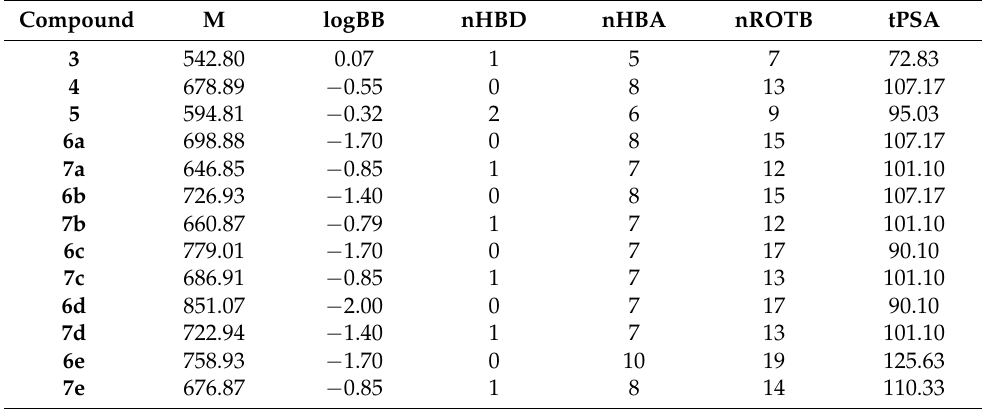
Table 8. Prediction of ADME properties of compounds 3 – 5 , 6a – 6e , and 7a – 7e